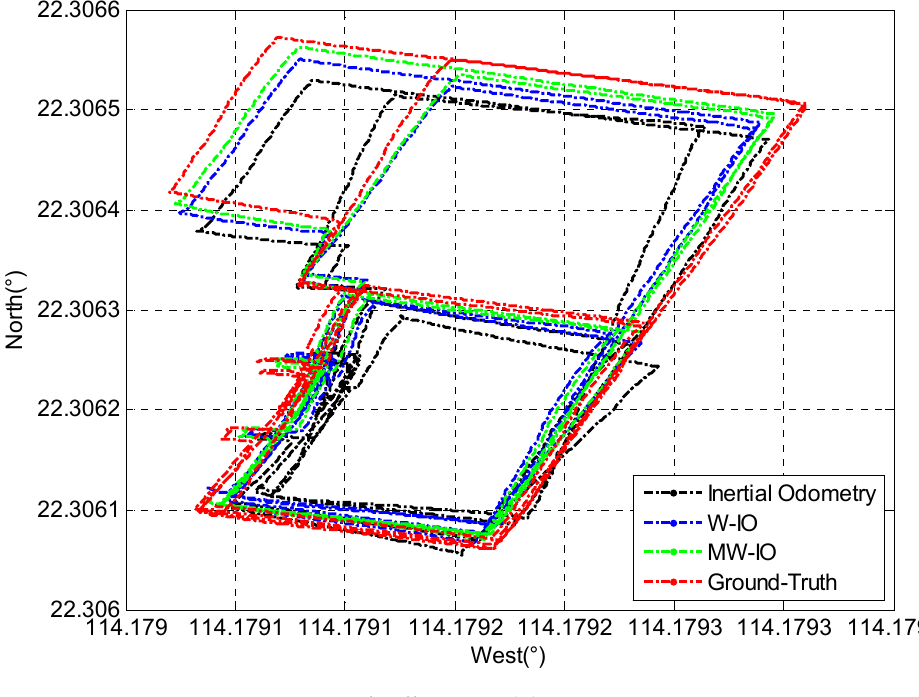
Figure 13. Trajectories Comparison of Different Models.